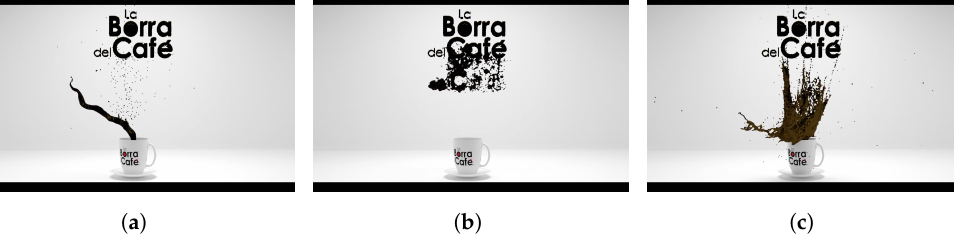
Figure 4. New website design element: coffee animation. Note: the total length for the animation was 25 s. ( a ) Coffee elevation frame. Second 3. ( b ) Coffee falling frame. Second 19. ( c ) Coffee explosion frame. Second 21.